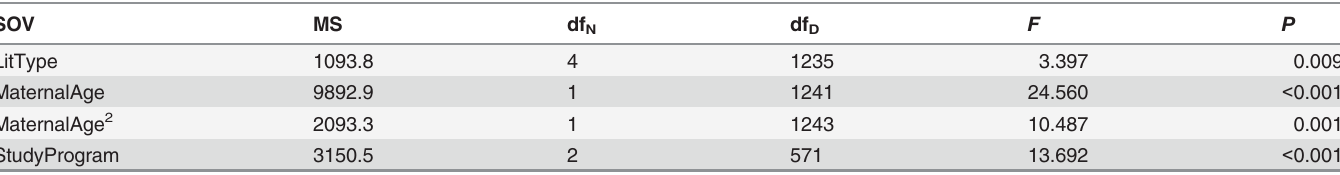
Table 1. Sources of variation utilizing restricted maximum likelihood estimation for a linear mixed-effects model assessing the influence of repro- ductive components on parturition date (Julian date) of singleton and twin white-tailed deer at Kerr Wildlife Management Area, Kerr County, TX from 1977 –